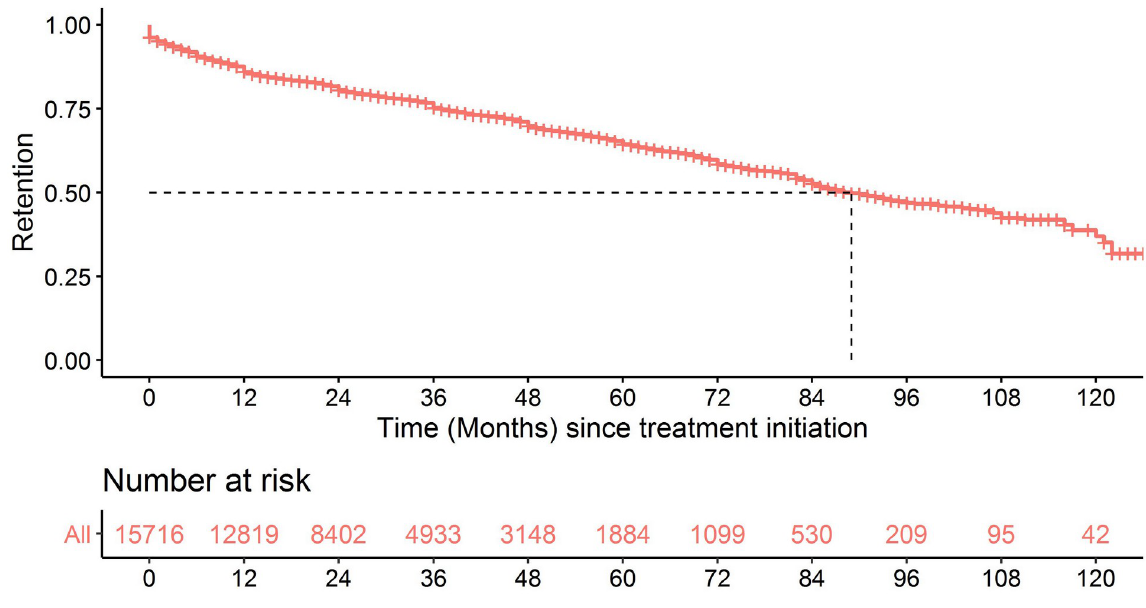
Fig 2. Kaplan–Meier plot of retention since ART initiation for the entire